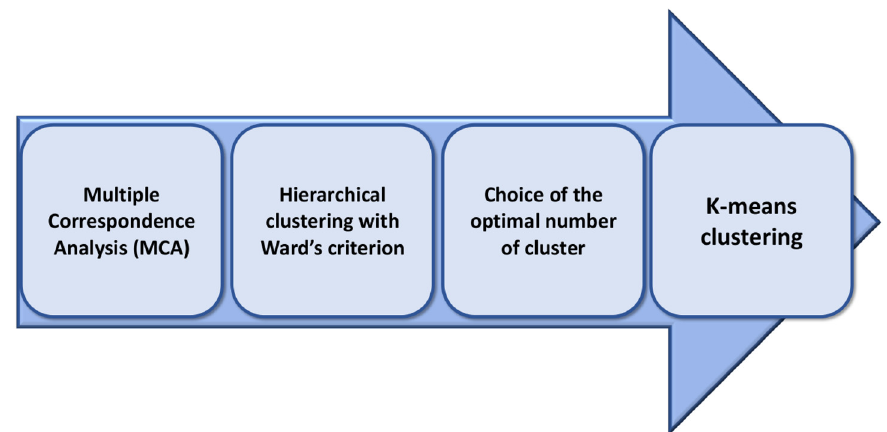
Fig 1. Flowchart of the proposed methodology. After a feature selection procedure based on the MCA algorithm, we implemented a hierarchical clustering procedure with Ward’s criterion and chose the optimal number of clusters based on the obtained dendrogram. Finally, we used the K-means algorithm to optimize the final partition.